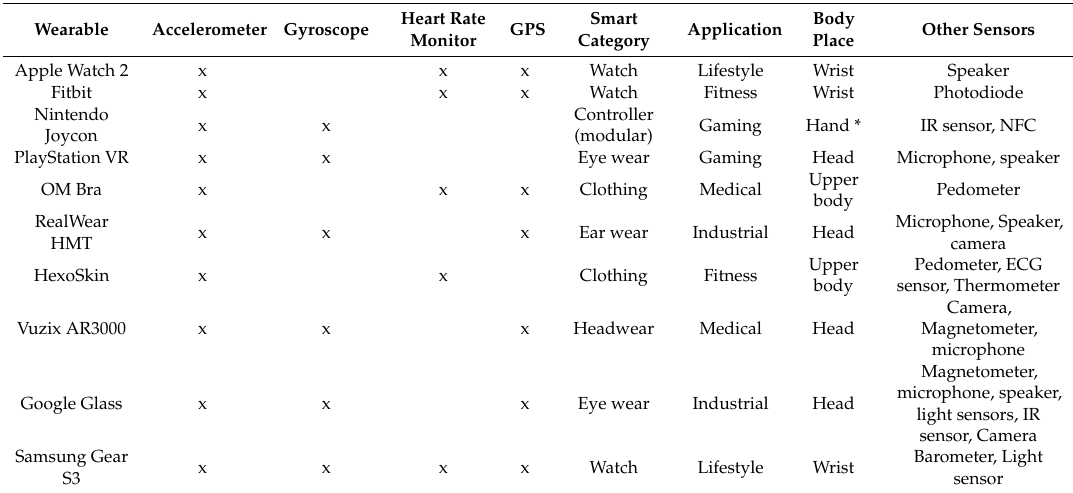
Table 1. Wearable technology in di ff erent industries; data taken from Vandrico [54].